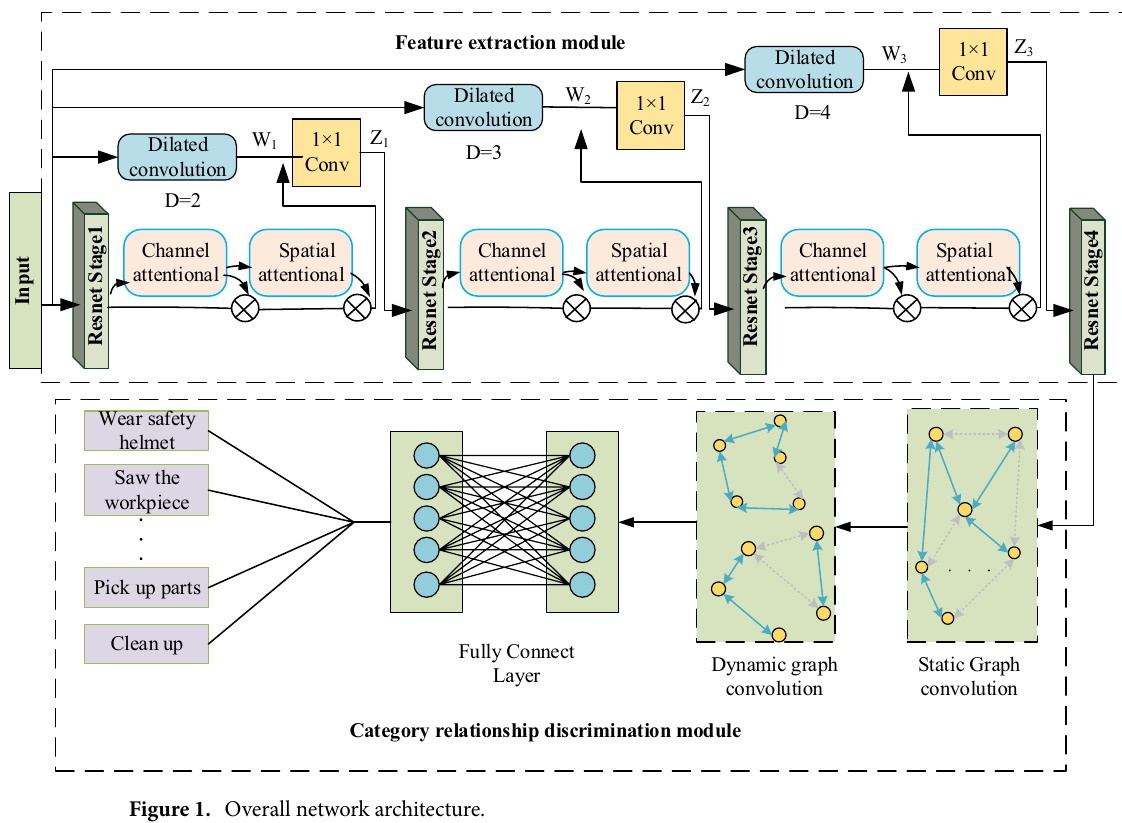
Figure 1. Overall network